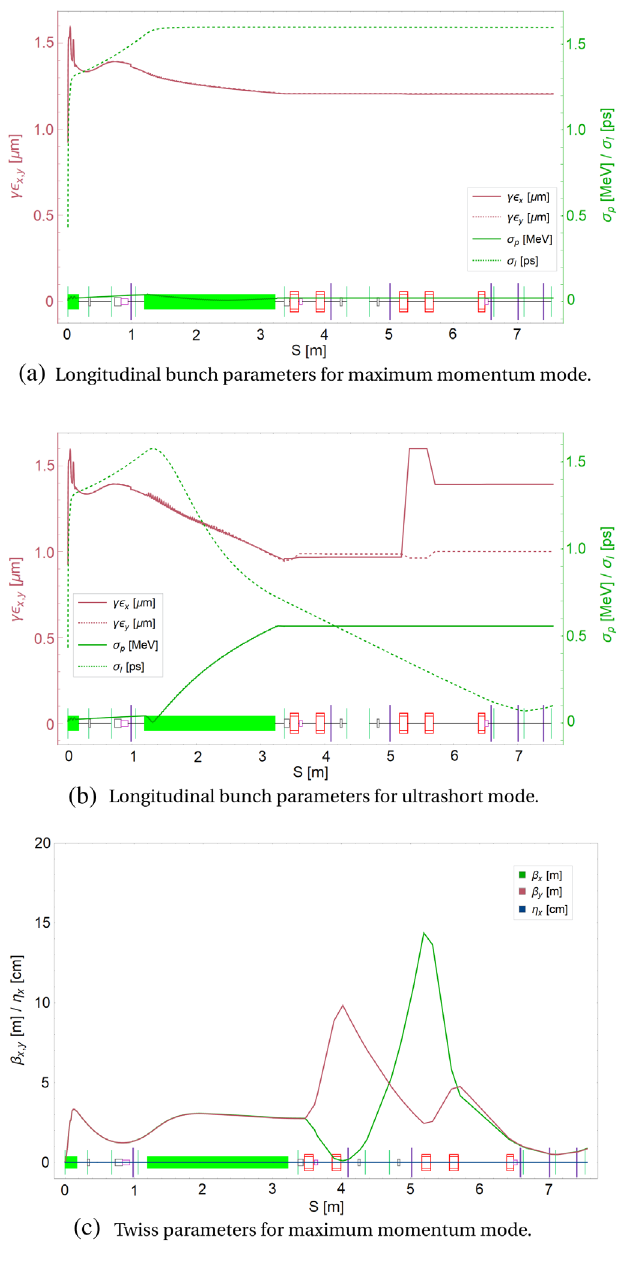
FIG. 9. Summary of the simulated beam properties at the CLARA FE straight on for a 70 pC bunch in two parameter